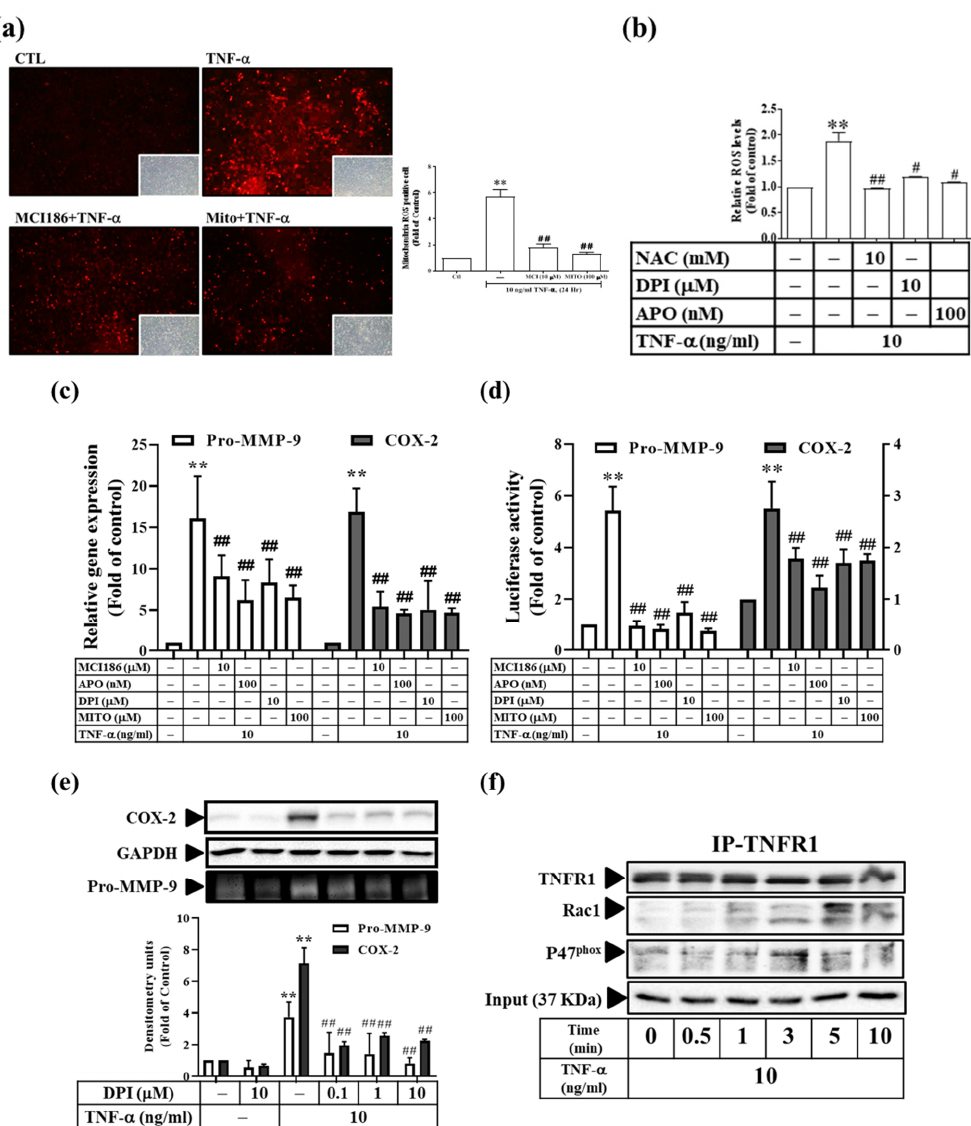
Figure 5. The ROS generated by the complex of TNFR1/TRAF2/Rac1/p47 phox participated in the TNF- α -induced upregulation of COX-2 and pro-MMP-9. ( a ) Cells seeded on glass slides were pre-treated with MCI186 and mito-TEMPO, followed by TNF- α treatment, then stained with MitoSOX™ Red reagent and photographed using a fluorescence microscope. ( b ) Cells were pre-treated with NAC, DPI, and APO, followed by TNF- α treatment. The cell lysate was collected, and the H 2 DCF fluorescence value was read. ( c , d ) Cells were pre-treated with MCI186, APO, DPI, and mito-TEMPO, followed by TNF- α treatment. ( c ) Real-time PCR was used to analyze the MMP-9 and COX-2 mRNA transcripts. ( d ) Luciferase assay was used to analyze the MMP-9 and COX-2 promoter activity. ( e ) Cells were pre-treated with various concentrations of DPI, followed by TNF- α treatment for 24 h (for COX-2) and 48 h (for MMP-9). MMP-9 enzyme activity was observed by gelatin zymography, and COX-2 expression was assessed by Western blotting. ( f ) The whole-cell lysate (input, 1 mg) was reacted with an anti-TNFR1 antibody. After the reaction, 50% protein A-agarose magnetic beads were mixed evenly at 4 ◦ C for 1 day. The antigen–antibody conjugates were collected and prepared as the electrophoretic sample. Western blotting was used to analyze the binding of TNFR1, Rac1, or p47 phox . The results are presented as the mean ± SD from 4–6 experiments and analyzed using one-way ANOVA followed by Dunnett’s post hoc test. ** p < 0.01, compared with the untreated group. # p < 0.05, ## p < 0.01, compared with the TNF- α treatment